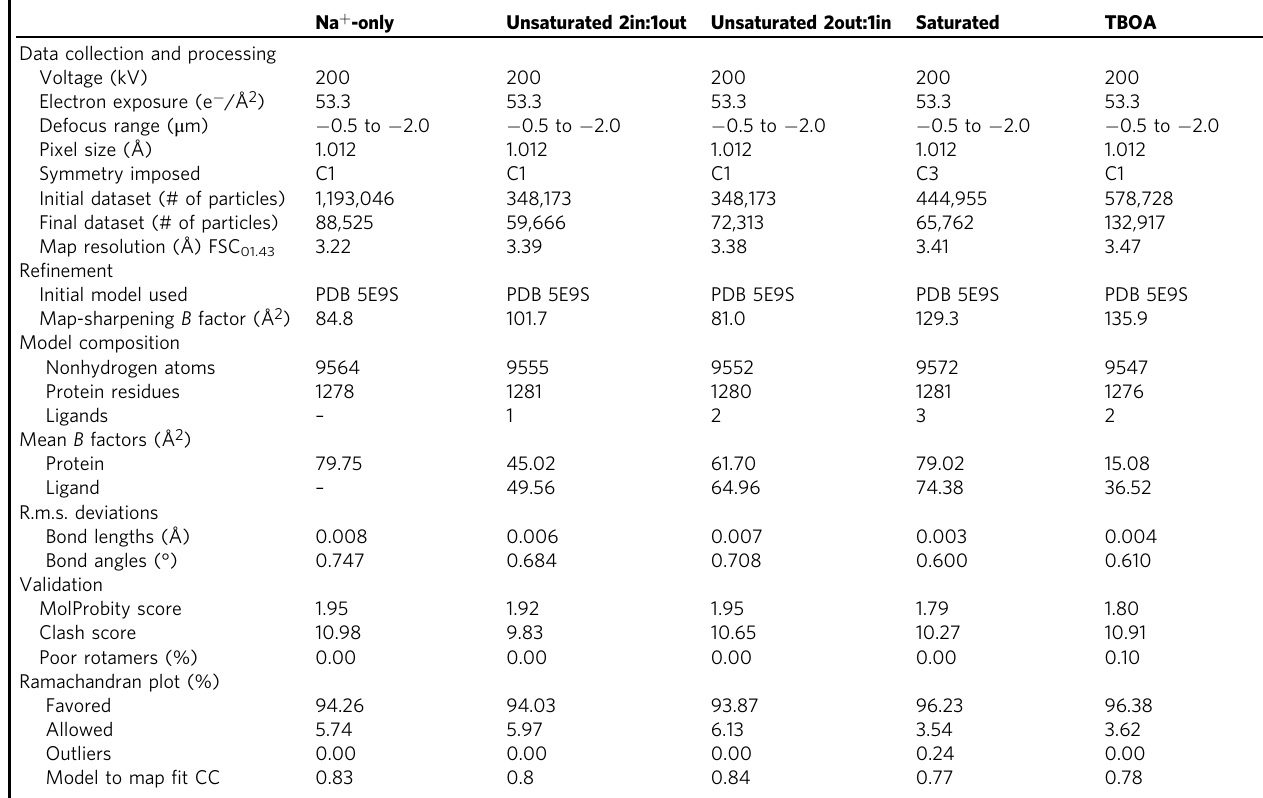
Table 1 Cryo-EM data collection, re fi nement and